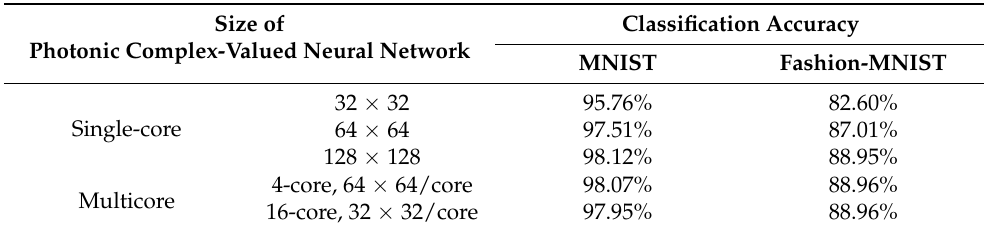
Table 3. Classification accuracies of different sizes of single-core and multicore PCNNs on the MNIST and Fashion-MNIST test sets.